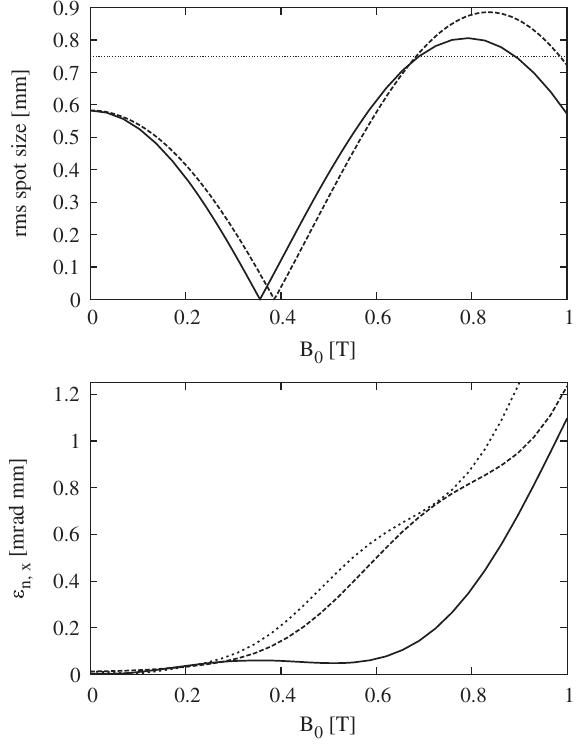
FIG. 23. Top: rms beam size versus strength of the solenoid field for a 5 MeV beam passing through a single-cell cavity (1.3 GHz, E 0 ¼ 50 MV = m, on crest). The beam starts outside of the solenoid with an rms size of 0.75 mm and travels an effective length of 5 cm to the entrance of the cavity. Dashed line, analytical result; solid line, numerical result. Bottom: Emittance versus strength of the solenoid field for a single-cell cavity (solid line), a two-cell cavity (dashed line), and a three-cell cavity (dotted